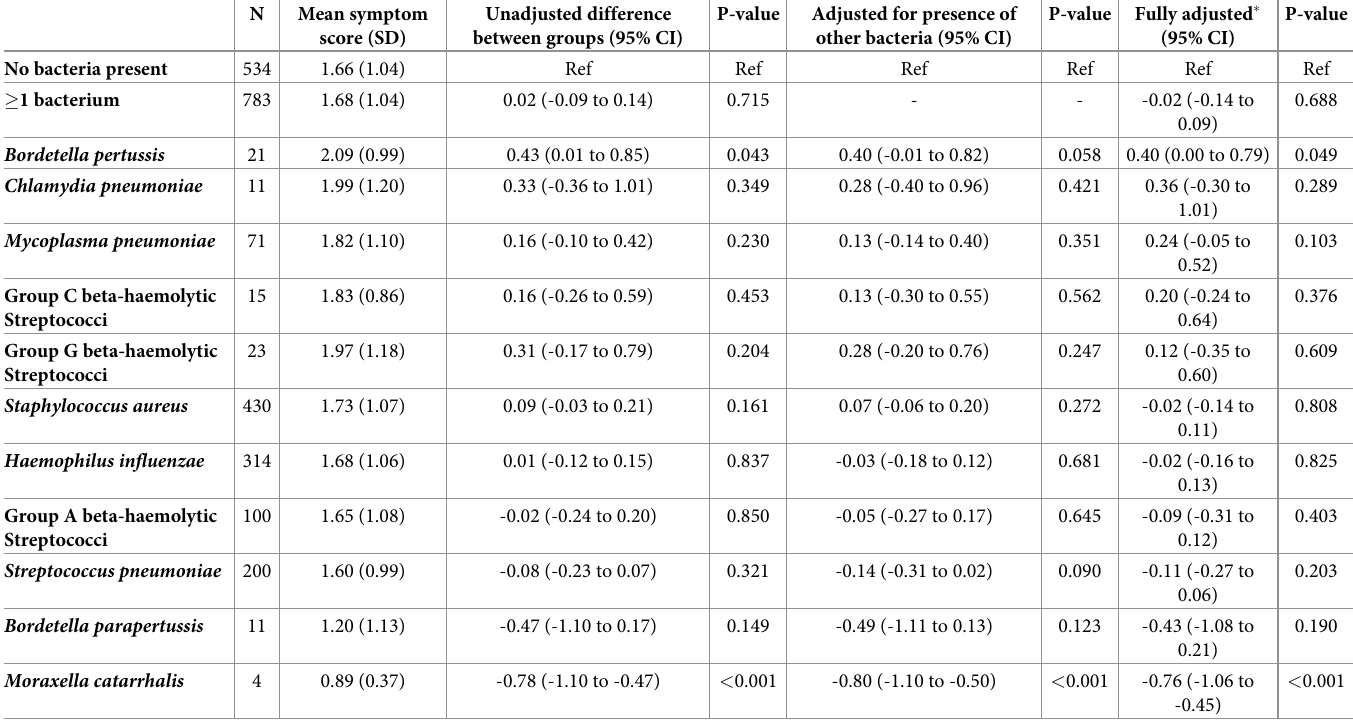
Table 3. Mean symptom severity between days 2–4 after initial illness presentation among children testing positive for respiratory bacteria.